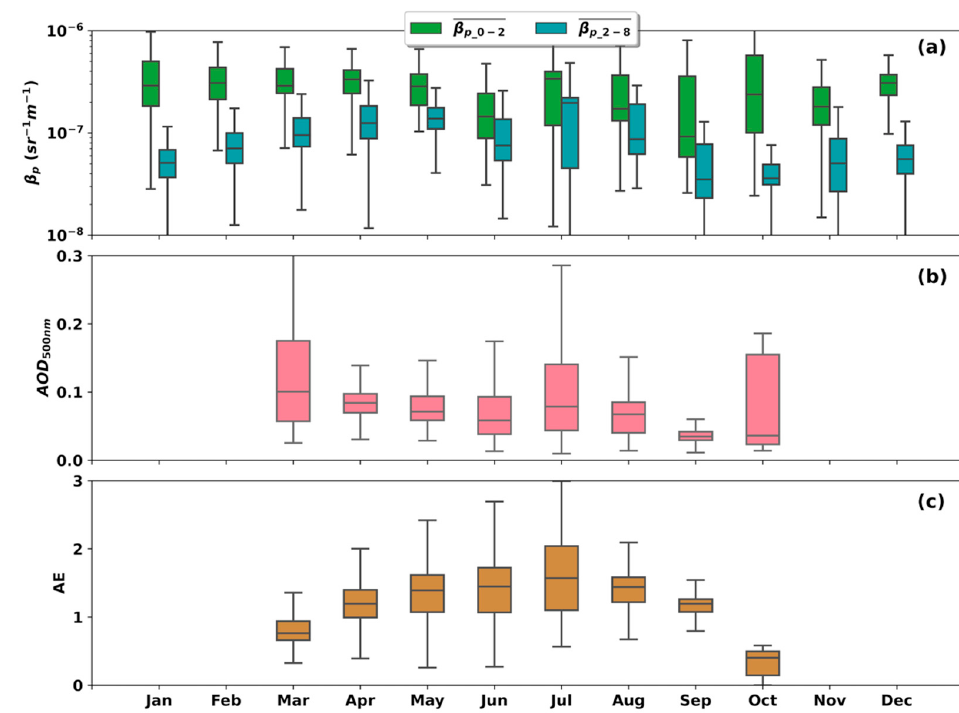
Figure 9. Monthly distributions of ( a ) mean β p between the surface and 2 km ( β p _0 − 2 ) and mean β p between 2 and 8 km ( β p _2 − 8 ); ( b ) MFRSR AOD at the wavelength of 500 nm (AOD 500nm ); ( c ) MFRSR derived Aerosol Ångström exponent (AE) between 415 and 870 nm.